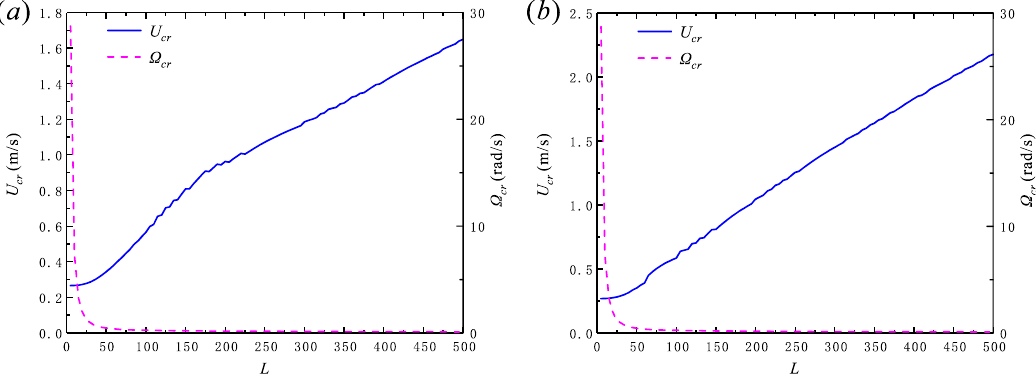
Figure 9. Leaching-tubing-like systems, theoretical variation of U cr and Ω cr with the increase of the pipe system length L . The results are based on the instability of the first prediction. ( a ) Leaching-tubing with α ch = 1.676 and r ann = 0.125. ( b ) Leaching-tubing with α ch = 1.676 and r ann = 0.25.